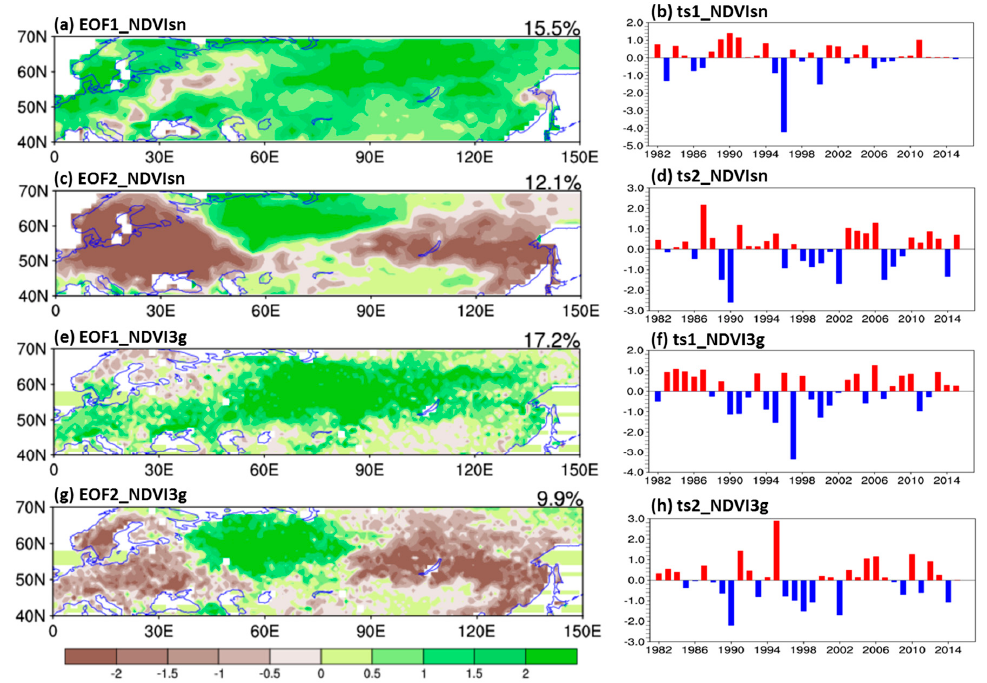
Figure 2. The first two EOF patterns and corresponding time-series obtained from spring NDVI over Eurasia for the period 1982–2015: ( a ) the mode of EOF1 in NDVIsn; ( b ) the time-series of EOF1 in NDVIsn; ( c ) the mode of EOF2 in NDVIsn; ( d ) the time-series of EOF2 in NDVIsn; ( e ) the mode of EOF1 in NDVI3g; ( f ) the time-series of EOF1 in NDVI3g; ( g ) the mode of EOF2 in NDVI3g; and ( h ) the time-series of EOF2 in NDVI3g. The variance explained by each EOF mode is shown on the right corner of figures in the left column.